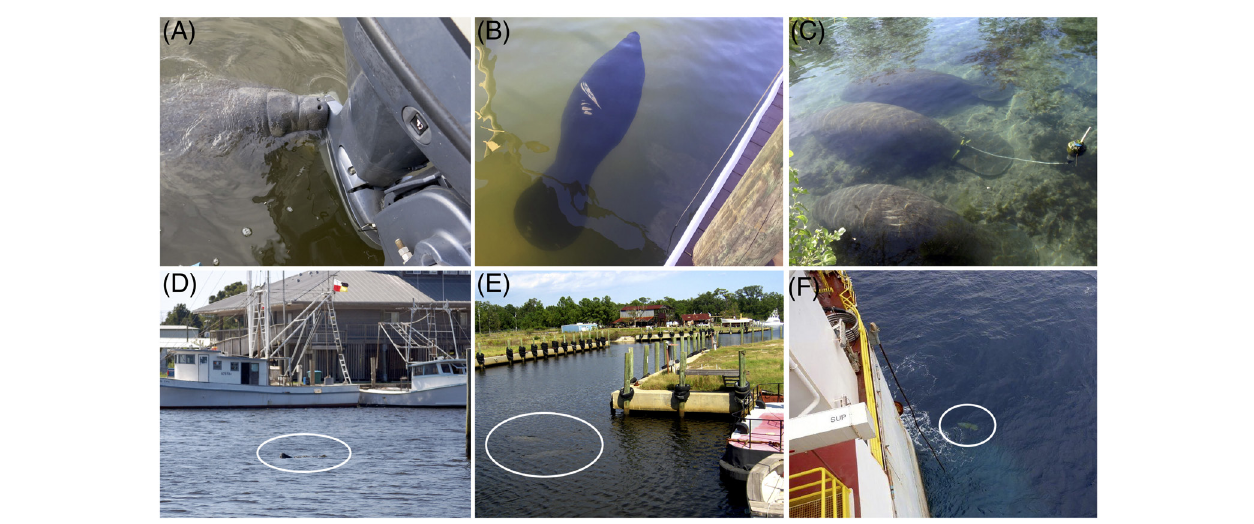
FIGURE 1 | Typical examples of manatee interactions with vessels and channels. Manatee nudging a boat motor in Horseshoe Beach, FL 2013 (A) . Fresh propeller scars on a manatee in Bayou St. John, AL 2018 (B) and healed propeller scars (bottom animal below tagged manatee) at Florida wintering ground 2012 (C) . Manatees traveling in local commercial and recreational harbors in Apalachicola, FL in 2010 and Bayou La Batre, AL 2008, respectively (D,E) . Manatee next to a seismic vessel in a fairway in the Gulf of Mexico 2013 (F) . Photo credits: DISL/MSN staff and